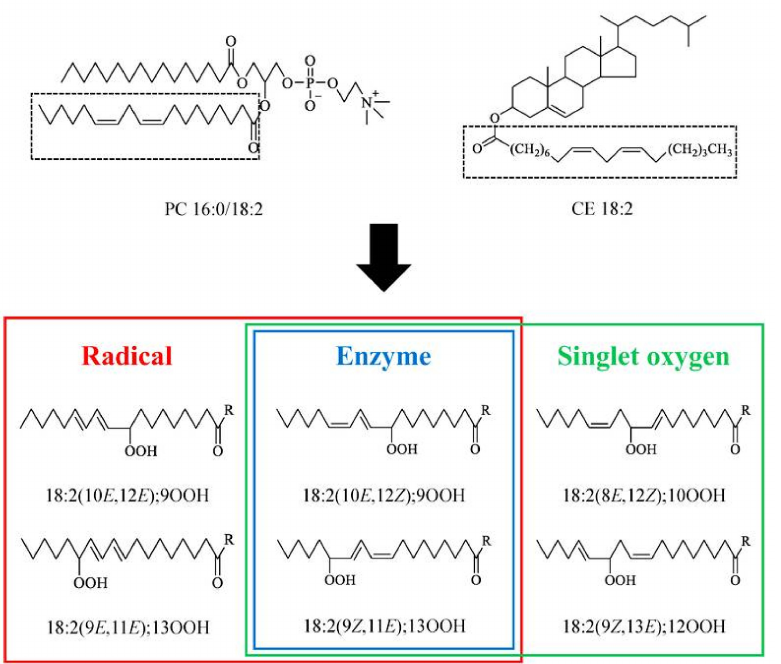
Figure 17. Proposed fragmentation pathway of ( A ) TAG 18:1/18:1/18:3 [OOH] and ( B ) TAG 18:1/18:1/18:1 [O] in canola oil. Reprinted with permission from [86]. Copyright 2019, Ameri- can Chemical Society.